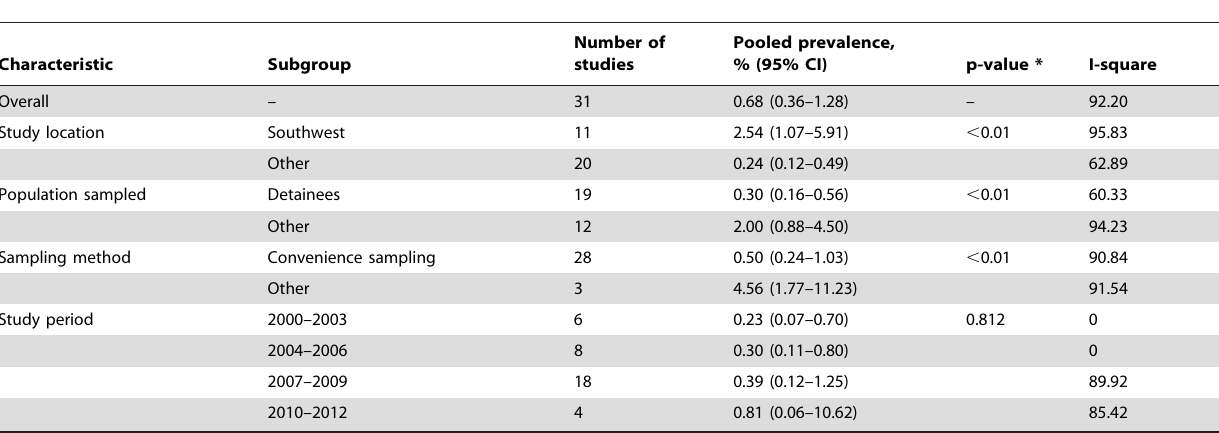
Table 2. Subgroup analyses for HIV prevalence among male clients of female sex workers in China.